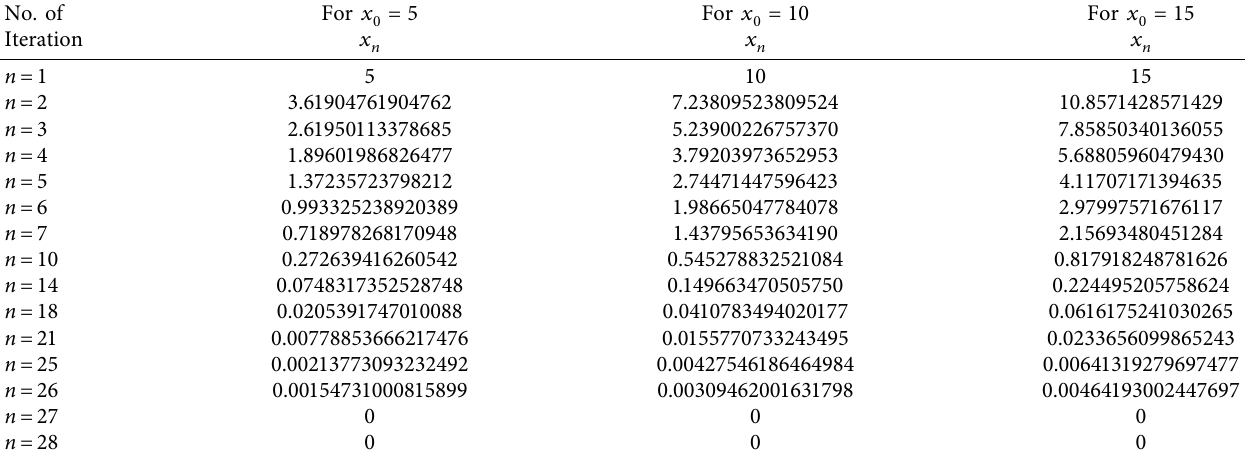
x � 5, x � 10, and x 0 0